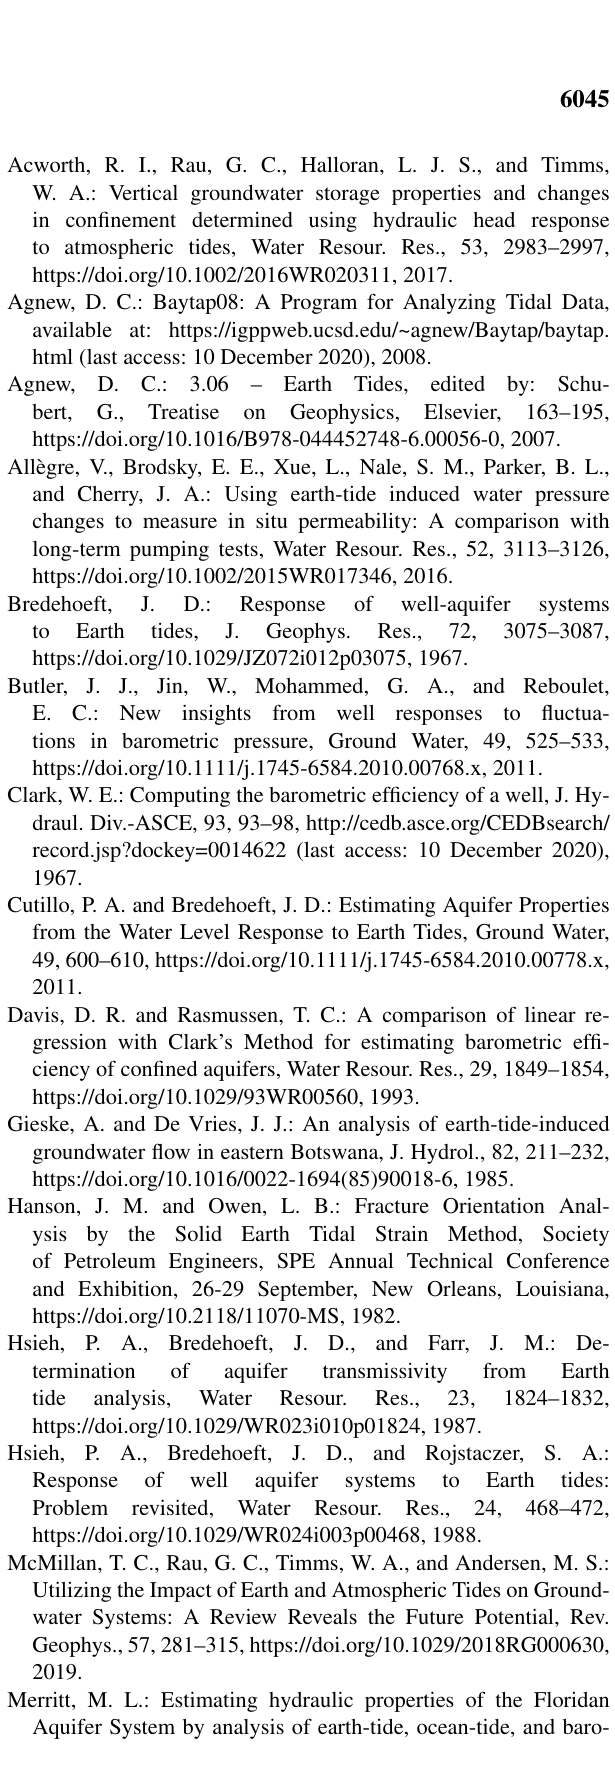
Figshare under https://doi.org/10.6084/m9.figshare.11316281 (Rau,